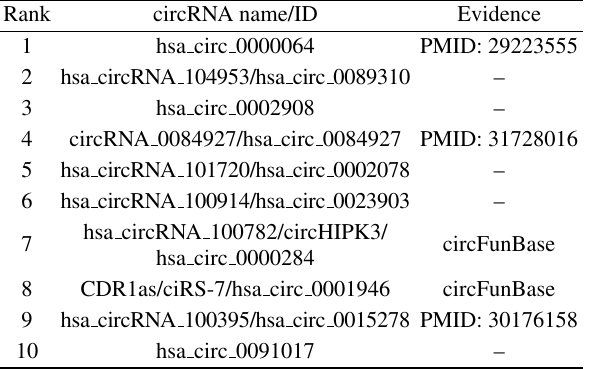
Table 2 Top 10 new lung cancer-related candidate